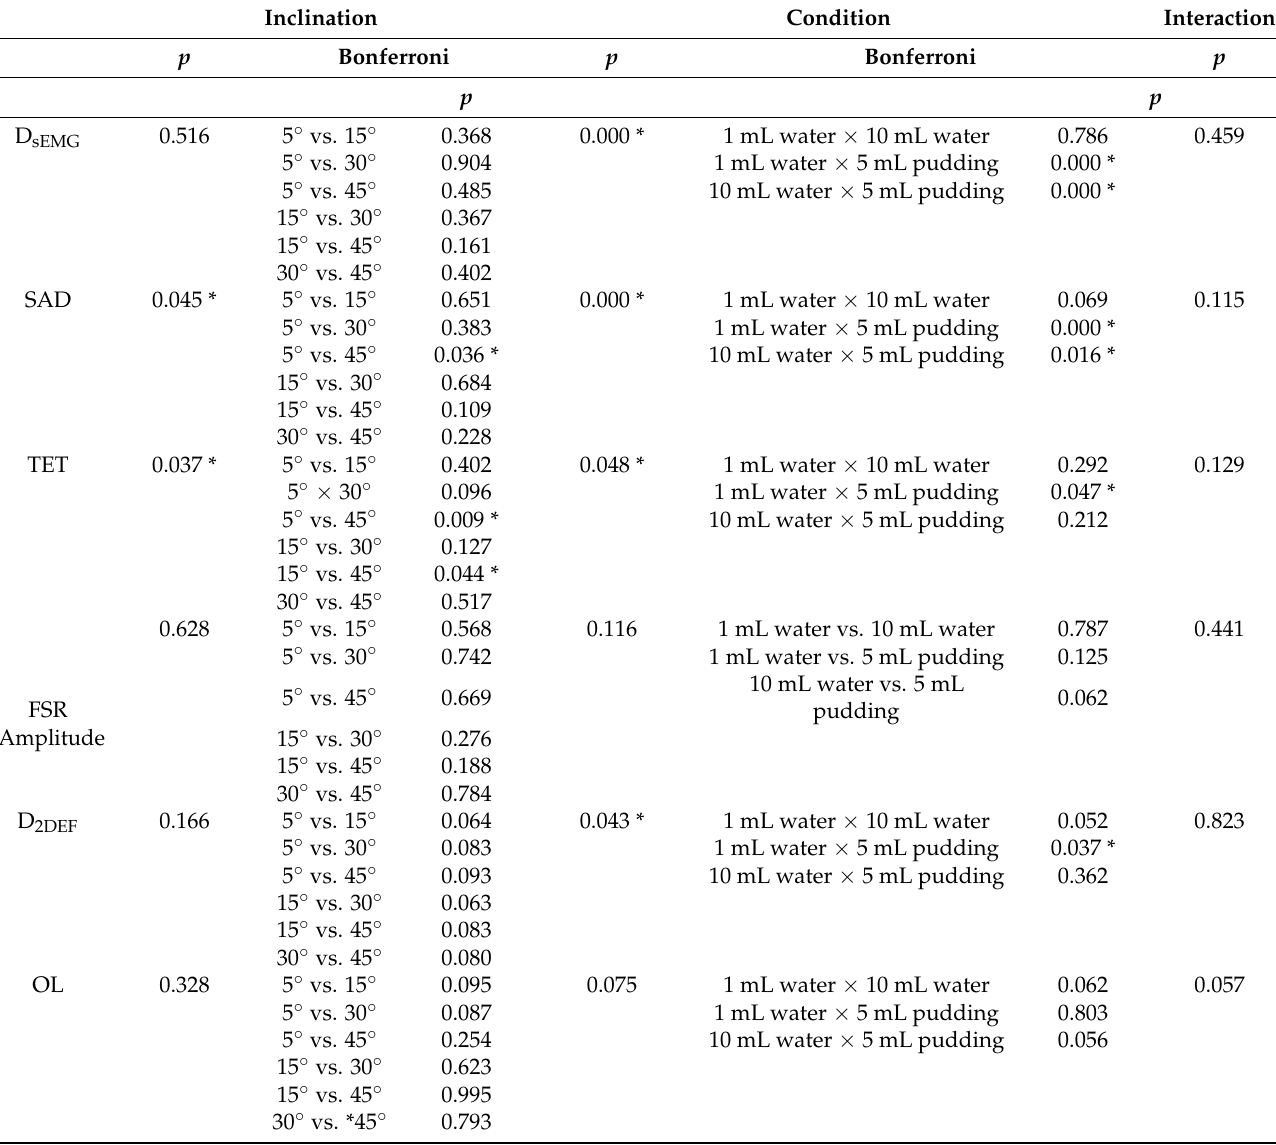
Table 4. Differences of variables between different inclination angles and food types.